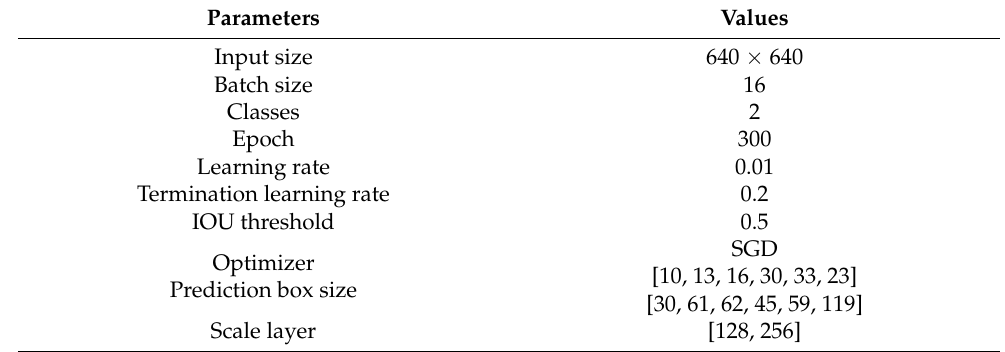
Table 2. YOLOv5s training